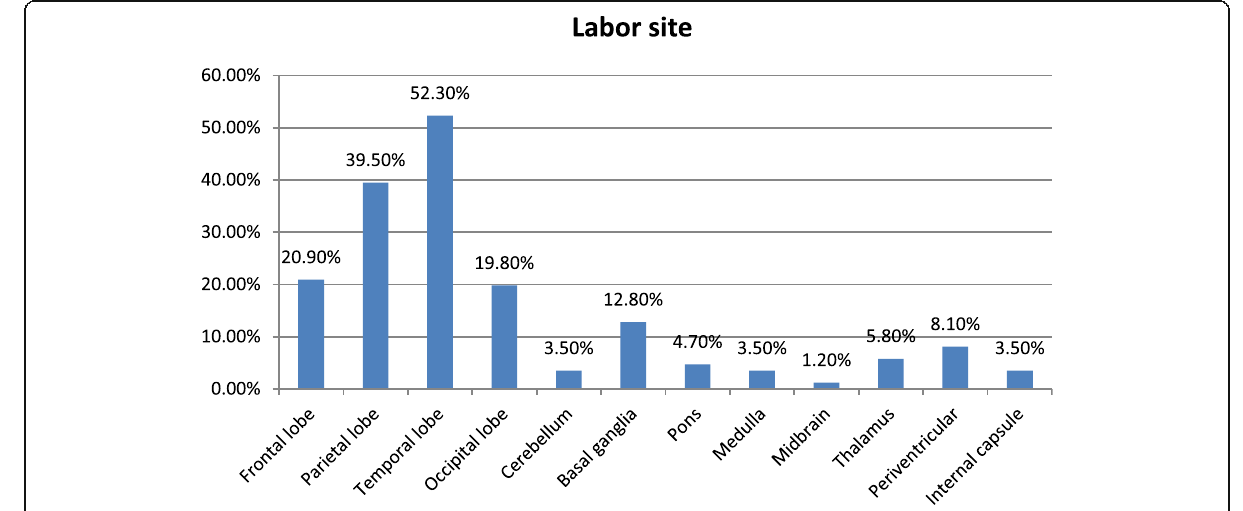
Fig. 3 Lobar site distribution of ischemic lesion among study group